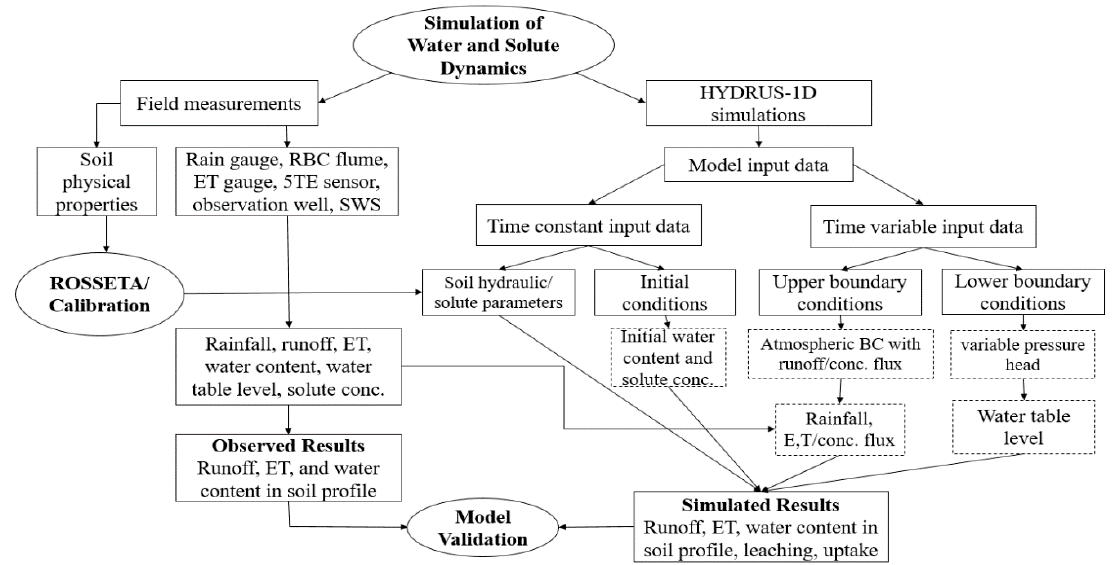
Figure 5. Flow chart presenting model simulation process and calculation of water and N balance components.